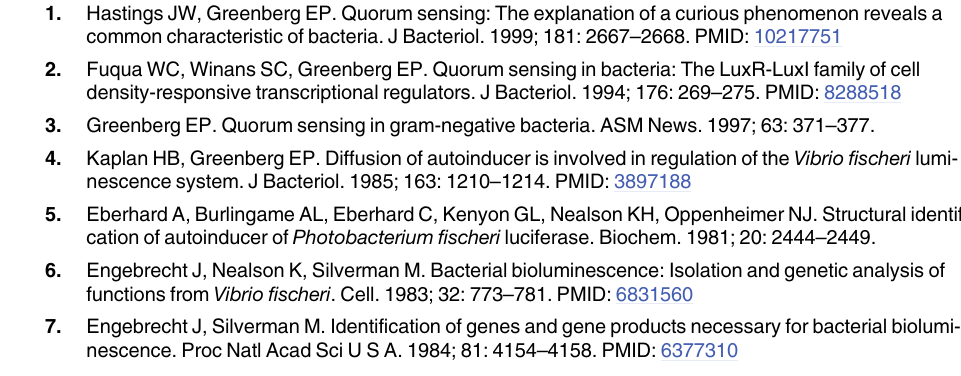
S1 Fig. Comparing data and fit for Δ ainRS mutants of the four LuxR variants. Each of pan- els ( A )-( D ) shows a representative luminescence dataset and fit for one of the Δ ainRS strains, where luminescence is measured as a function of C8-HSL and 3OC6-HSL concentration. The vertical axis indicates luminescence data and fit in units of fluorimeter counts on a linear scale, although the least-squares fitting was performed on a logarithmic scale (see Methods and Fig 3). The lower figure of each group shows the simple residual, data — fit , on a linear scale. (TIF) S2 Fig. Correlation between estimated absolute parameters. The figure shows correlation between estimated absolute interaction parameters for C8-HSL (horizontal axes) and 3OC6-HSL (vertical axes), for the four LuxR variants in Δ ainR mutants. Each point represents parameter values obtained in one of the 150 fits performed for each LuxR. The color code (blue = LuxR MJ1 , green = LuxR ES114 , red = LuxR A , yellow = LuxR B ) indicates the LuxR variant studied in the fit. Unlike in Fig 7, the scaled parameters ( k , k , k , k ) obtained from fitting are 1 2 A B , K , K , K in nM) by assuming [LuxR ] ’ 33 μ M. Each converted to absolute parameters ( K 1 2 A B 0 point represents one fit result (out of 150 results total) obtained for one strain. Panels ( A ) and , K ), and lux binding ( K , K ) respectively. The ( B ) show results for complex dissociation ( K 1 2 A B black dashed line in each panel corresponds to equality between C8-HSL and 3OC6-HSL pa- = K , or K = K . The larger shaded circles highlight (with the same color code) rameters; K 1 2 A B the median value obtained for each LuxR. (TIF) S1 Table. Estimated absolute dissociation constants. Absolute dissociation constants for the model of Fig 1, estimated from fit results and an assumed intracellular LuxR concentration of 33 nM. The first value given for each parameter is based on the median fit result for that pa- rameter; the indicated range encompasses the 20th to 80th percentile of the fit results.